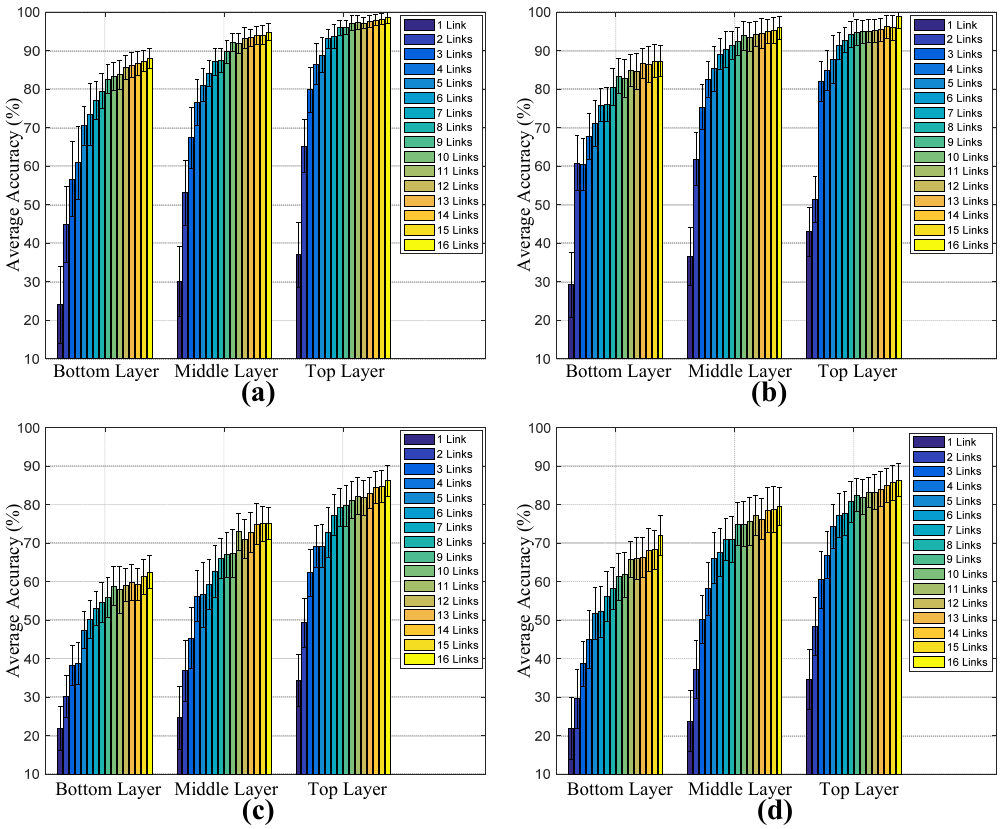
Figure 10. Average correct recognition rates as a function of the number of fused links. ( a ) VQ with LOS; ( b ) HMM with LOS; ( c ) VQ with NLOS; ( d ) HMM with